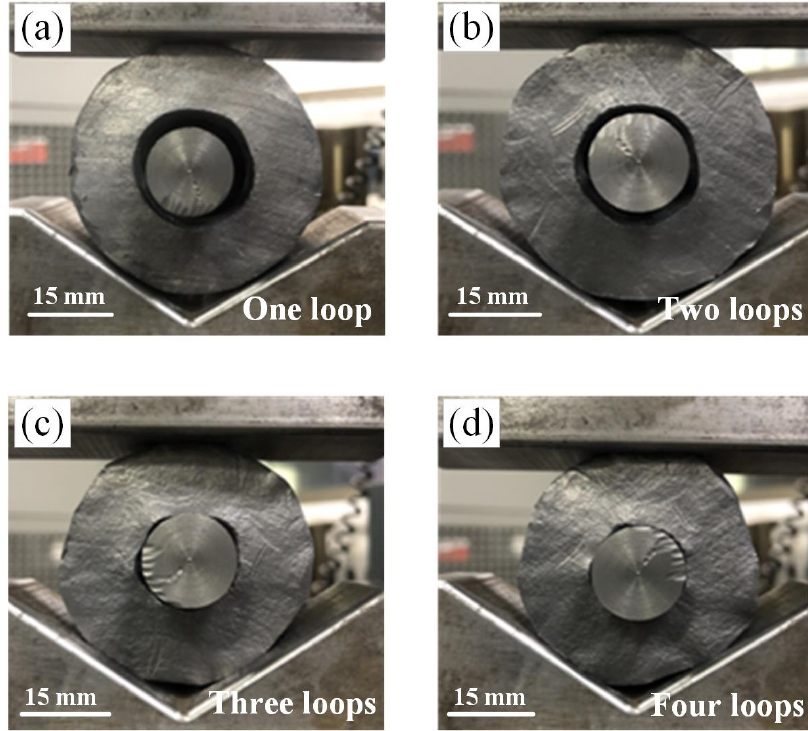
Figure 16. The inner hole variation of the shrinkage ratio experiment: ( a ) one loop; ( b ) two loops; ( c ) three loops; ( d ) four loops. Table 4. The variation of outer and inner diameters.